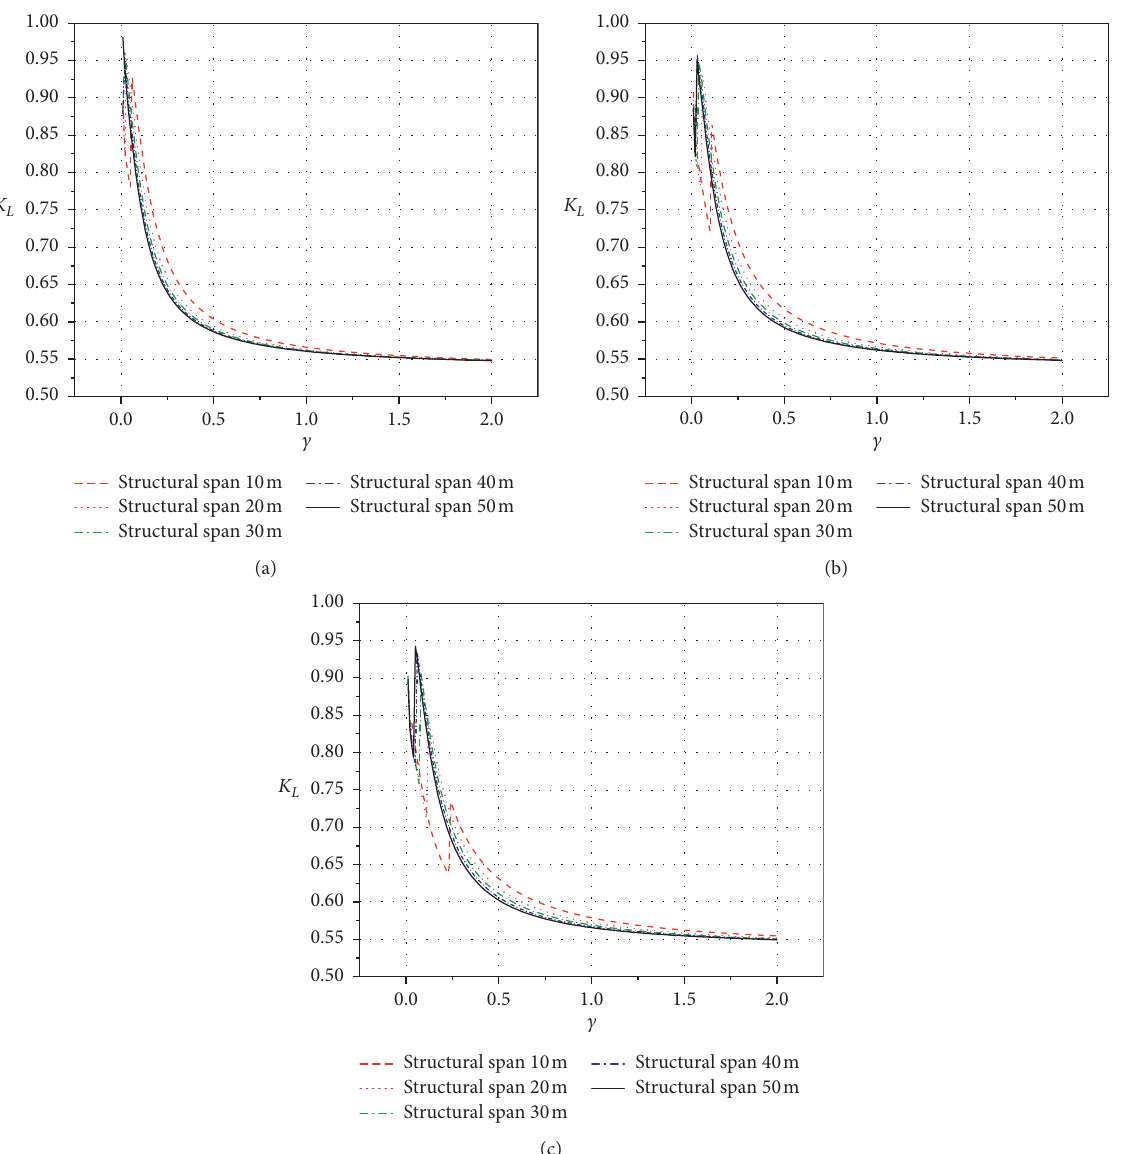
Figure 6: Equivalent load transformation factors of fixed end one-way members using Baker’s formula parameters: (a) W � 1kg. (b) W � 10kg. (c) W �